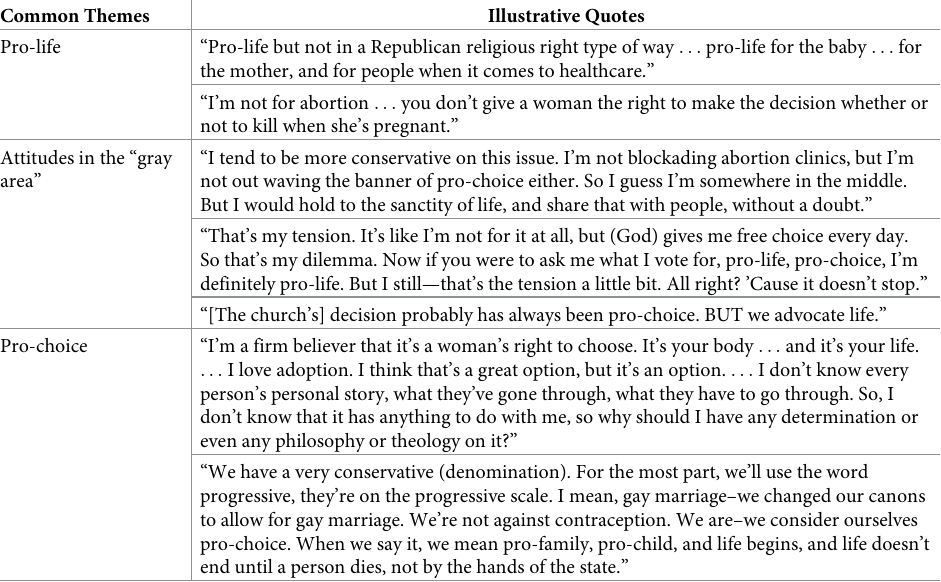
Table 2. Illustrative quotes of abortion